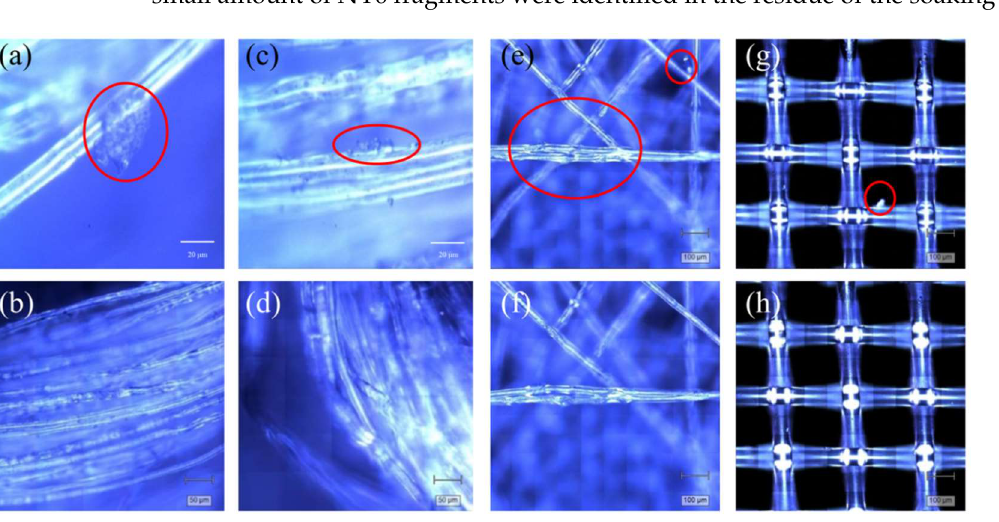
Figure 5. Surface morphologies of the string of samples B ( a , b ), the string of sample C ( c , d ), the non-woven filter bag ( e , f ), and the woven filter bag ( g , h ) before and after soaking, respectively.